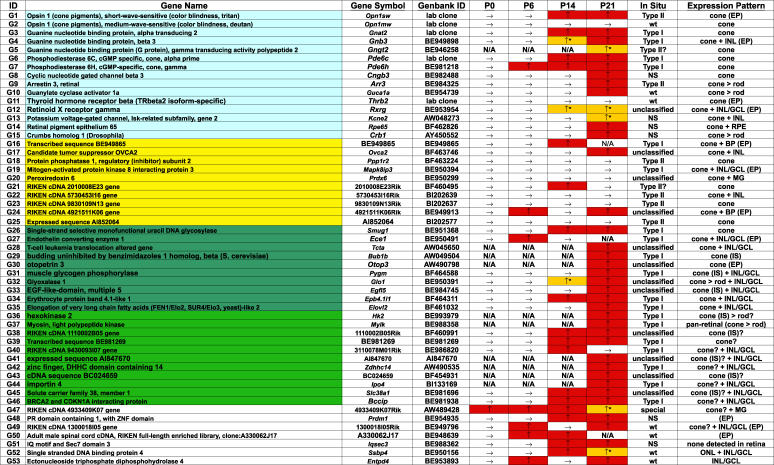
Cone-Specific and Cone-Enriched Genes Evaluated in the rd7 Mutant by Microarray and In Situ HybridizationThe color coding of text in the column “Gene Name” is as follows: light blue (G1–G15), genes previously reported in the literature to have cone-specific or cone-enriched patterns of expression; yellow (G16–G25), novel cone genes identified in an unrelated study (unpublished data); dark green (G26–G36), novel cone genes identified in the present study that were up-regulated in rd7; light green (G37–G46), additional genes found to be up-regulated in rd7 by microarray in the present study but that had either weak or inapparent cone-specific signal on in situ hybridization; white (G47–G53), additional genes up-regulated by microarray at two different timepoints but with either unusual expression patterns or nonconfirmatory in situ hybridizations. The column “ID” contains identifiers used in the present paper to refer to specific genes. “GenBank ID” contains the GenBank accession number of the clone used to make the probe for in situ hybridization. Within this column, “lab clone” indicates that the probe used for in situ hybridization derived from a clone in our laboratory. The region of the gene to which it corresponds is indicated in Table S1. Columns “P0” through “P21” contain the results of microarray experiments at the given postnatal dates. P0, P6, and P14 time points represent analyses on cDNA microarrays; the P21 time point represents data from an Affymetrix microarray (mouse genome 432 2.0). A red cell with a single up arrow indicates that the gene in question was up-regulated in three out of three microarrays at that time point (as described in Materials and Methods). Those cells labeled orange with a single up arrow and asterisk indicate that the gene in question was up-regulated in two out of three microarrays at that time point. The column “In Situ” lists the type of derepression seen for the gene in question in the rd7 mutant retina (type I and type II are described in the main text). Genes designated “unclassified” represent patterns of derepression that were difficult to classify as either type I or type II (see main text for more details). “Wild type” in this column indicates that the in situ hybridization pattern in the rd7 mutant retina was not different from the wild-type pattern; and “special” indicates a special pattern of expression discussed more fully in the main text. The column “Expression Pattern” contains a concise description of the wild-type expression pattern of the gene in question. In the case of genes for which no signal was obtained on in situ hybridization in the present study, the specified expression pattern derives from reports in the literature. Within this column, “cone > rod” indicates that the gene is expressed in all photoreceptors, but at higher levels in cones than rods; “cone?” indicates very weak staining in a cone-like distribution.BP, bipolar cells; EP, early photoreceptor expression pattern; IS, inner core segment localization; MG, Müller glia; N/A, not available on the microarray; NS, no signal detected on in situ hybridization; RPE, retinal pigment epithelium.